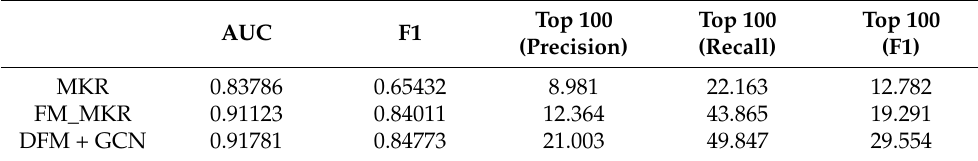
Table 3. The results of the AUC and f1 on CTR prediction based on the datasets of ml1m-kg1m. AUC